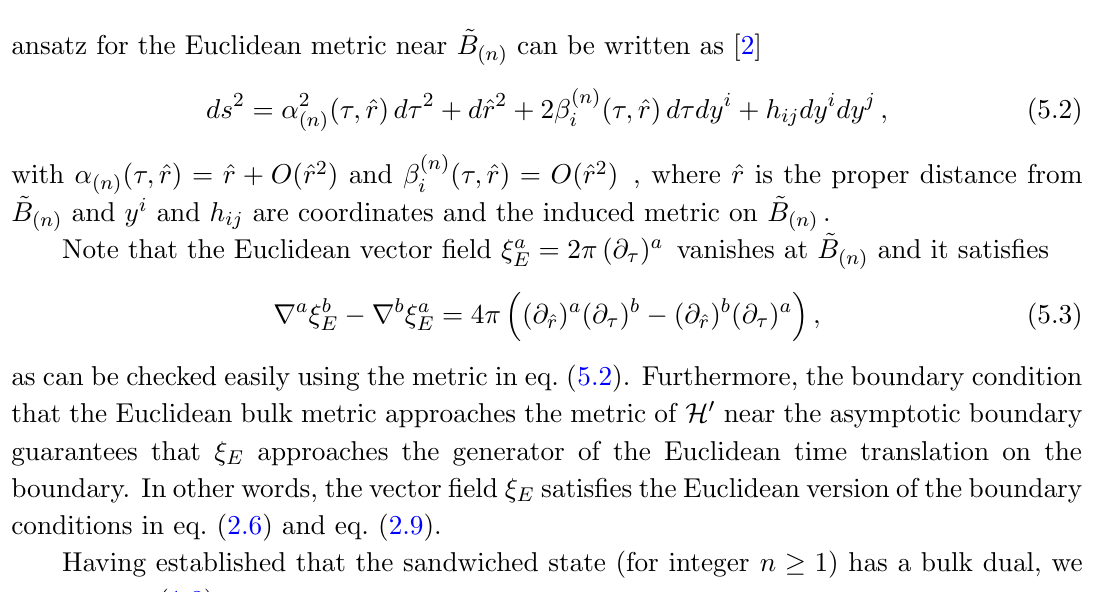
Figure 3 . The Euclidean bulk geometries dual to the boundary states (cid:27) ( left ) and (cid:26) ( right ). (3) H d (cid:0) 1 . The Euclidean circle on the boundary contracts as The boundary B (shown in blue) is S 1 (cid:2) one goes deep into the bulk and it is shrinks to zero size at a codimension-2 surface marked with a red dot. The shaded region on the boundary of denotes the smeared operators inserted in M (3) the path integral representation of the sandwiched state, (cid:26) ; see (cid:12)gure 1. The smearing function (3) provides the Z 3 -symmetric boundary conditions for the bulk matter (cid:12)elds. (This (cid:12)gure is inspired by (cid:12)gure 2 of